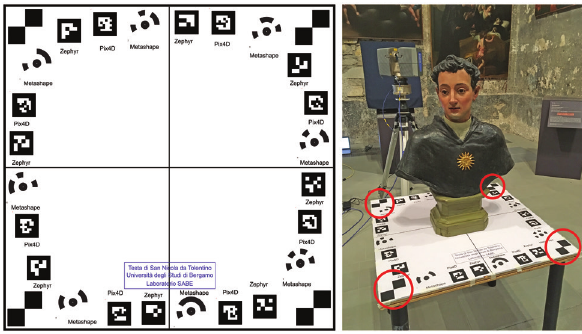
Figure 3. The statue and the markers used to georeference the model